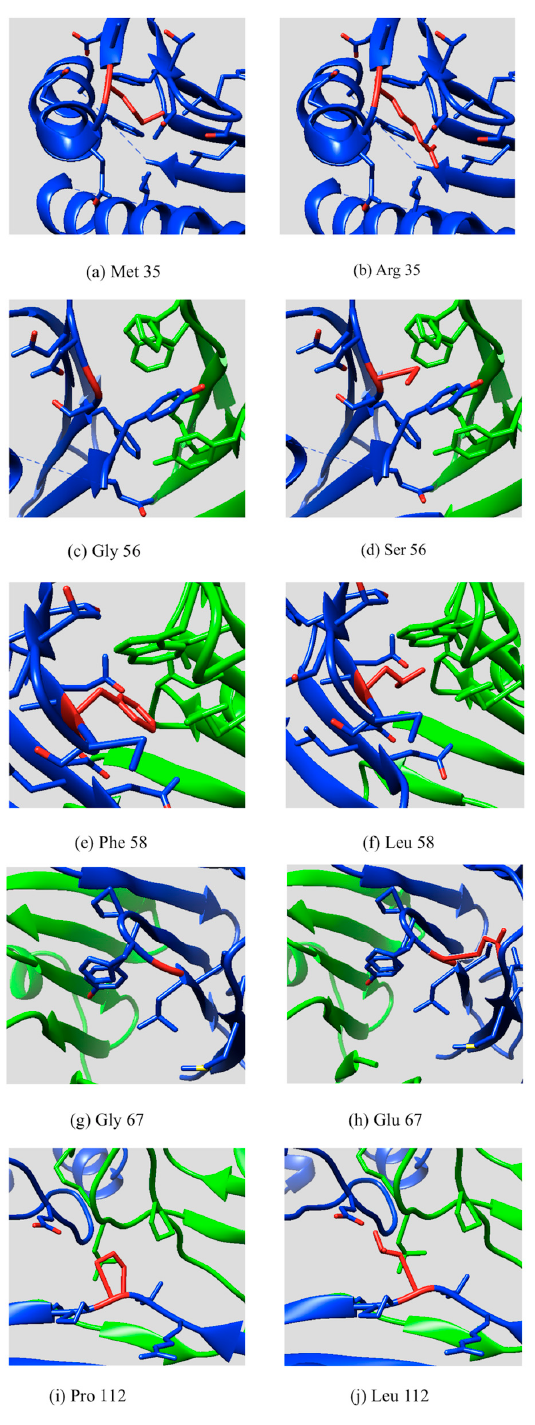
Figure 3. The side chain conformation of five disease-causing mutations mapped onto SpmSyn: ( a ) Part of SpmSyn zoomed at WT position of Met35; ( b ) Part of SpmSyn zoomed at MT position of Arg35; ( c ) Part of SpmSyn zoomed at WT position of Gly56; ( d ) Part of SpmSyn zoomed at MT position of Ser56; ( e ) Part of SpmSyn zoomed at WT position of Phe58; ( f ) Part of SpmSyn zoomed at MT position of Leu58; ( g ) Part of SpmSyn zoomed at WT position of Gly67; ( h ) Part of SpmSyn zoomed at MT position of Glu67; ( i ) Part of SpmSyn zoomed at WT position of Pro112; ( j ) Part of SpmSyn zoomed at MT position of Leu112; The side chain of WT and MT position is shown in red. Two different chains of the dimer are shown in blue and green.